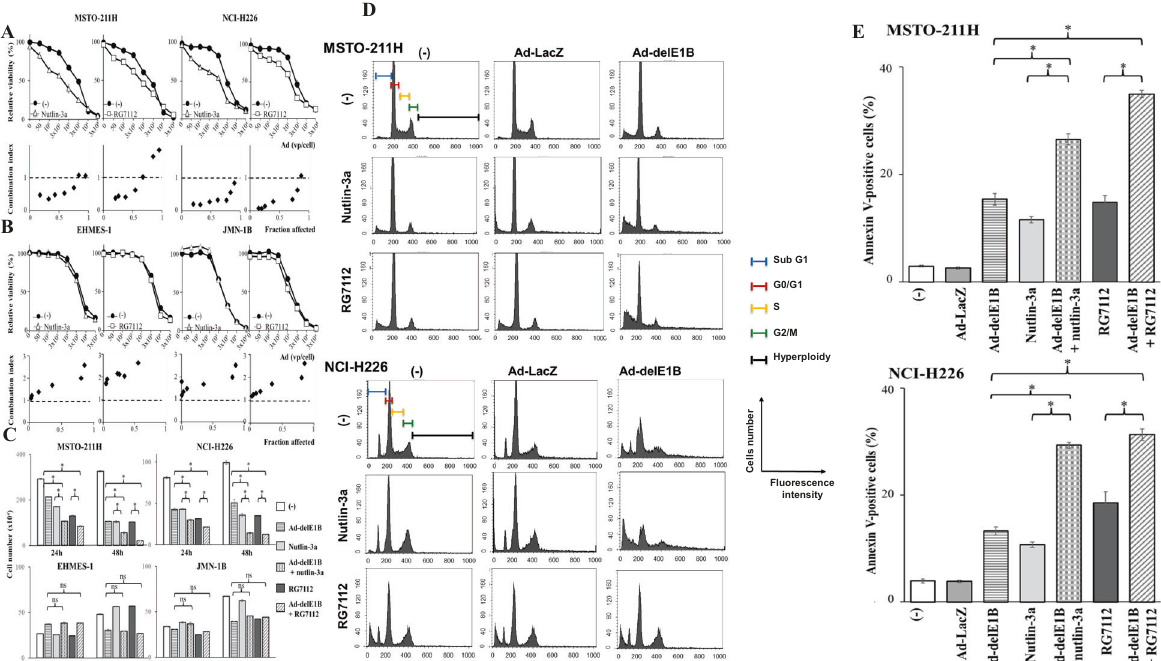
Fig. 3 MDM2 inhibitors produced synergistic growth inhibitory effects and changed cell cycle progression with Ad-delE1B on wild-type p 53 cells. A Wild-type p53 or B mutated p53 cells were infected with various vp of Ad-delE1B for 2 days, and then treated with nutlin-3a (MSTO-211H: 0.5 µM, NCI-H226, EHMES-1, and JMN-1B: 1 µM) or RG7112 (0.15 µM) for further 2 days. The cell viabilities were measured with the WST agent. Relative viability was calculated based on untreated cells. Averages and SE bars are shown ( n = 3). CI values were plotted at respective Fa points. CI < 1, CI = 1 and CI > 1 indicate synergistic, additive, and antagonistic actions, respectively. C Cells were infected with Ad- delE1B (MSTO-211H and NCI-H226: 1.5 × 10 3 vp/cell, EHMES-1 and JMN-1B: 3 × 10 3 vp/cell) for 2 days, and then treated with nutlin-3a (MSTO- 211H and NCI-H226: 5 µM, EHMES-1, and JMN-1B: 15 µM) or RG7112 (MSTO-211H and NCI-H226: 3 µM, EHMES-1 and JMN-1B: 10 µM). Live cells numbers were then counted on 24 and 48 h later. ns not signi fi cant, * p < 0.001 (GraphPad Prism 6, La Jolla). D Cells were infected with Ad- delE1B or Ad-LacZ (3 × 10 3 vp/cell) for 2 days, and then treated with nutlin-3a (5 µM) or RG7112 (5 µM). Cell cycle distribution was determined with fl ow cytometry. Representative histogram of MSTO-211H cells at 36 h after treatment with the inhibitor and that of NCI-H226 at 48